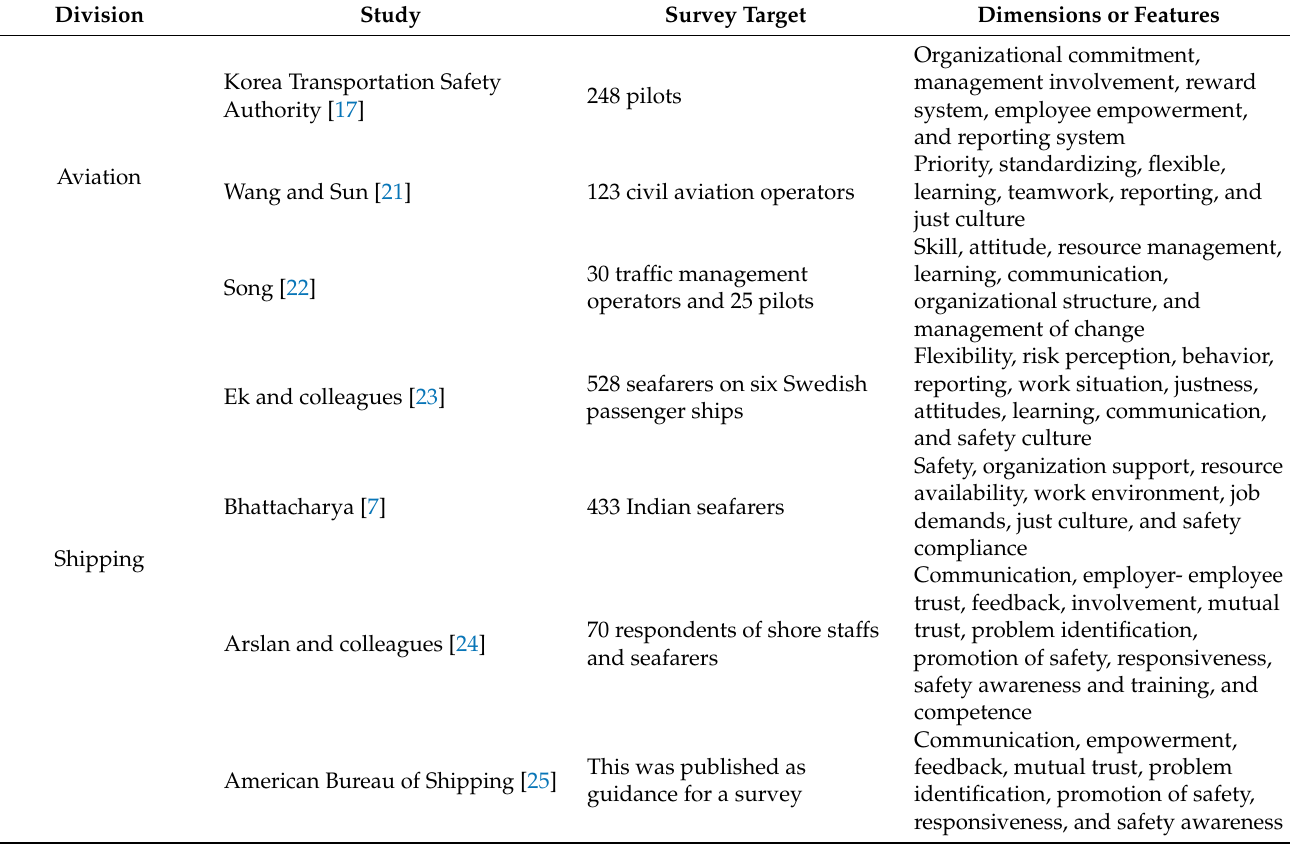
Table 2. Summary of safety culture dimensions (Source: adapted from